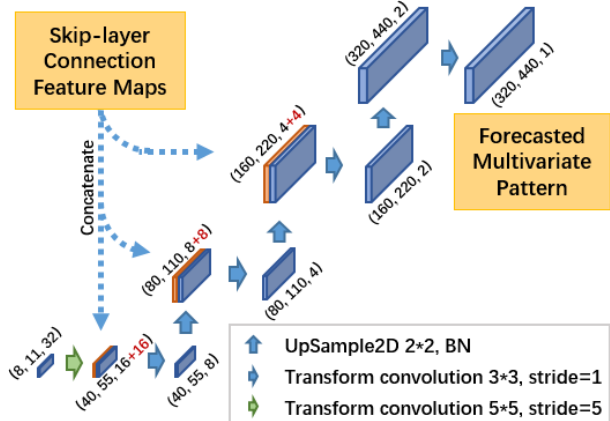
Figure 9. A detailed structure for decoder, skip-layer connections from encoder for helping end-to-end learning to restore the fore- casted patterns at different spatial